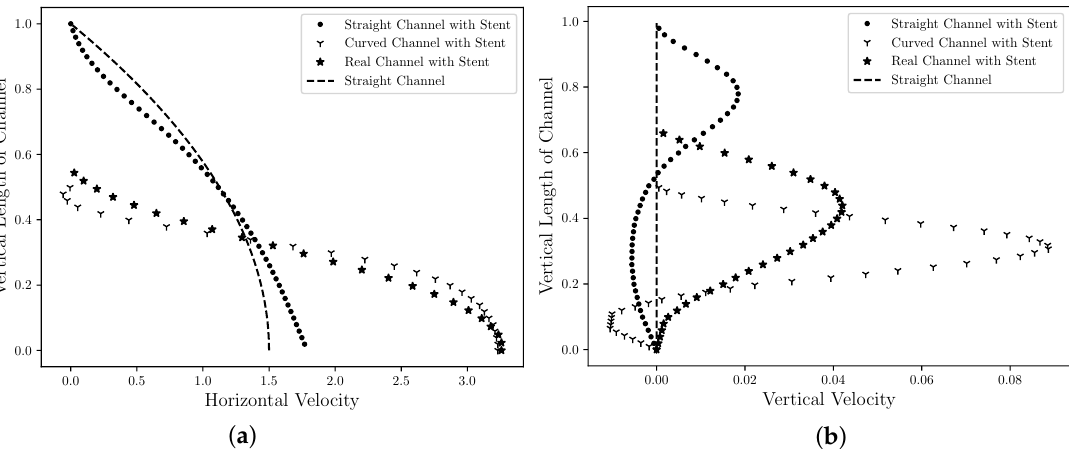
Figure 7. The state steady of the blood horizontal ( a ) and vertical ( b ) velocities profiles in the middle ( x = 5.0 R) for the straight channel, the curved channel and the real channel with drug-eluting stent. The velocities values are presented by nondimensional values and it is estimated that the drug-eluting stent implantation modifies the velocities profiles for all